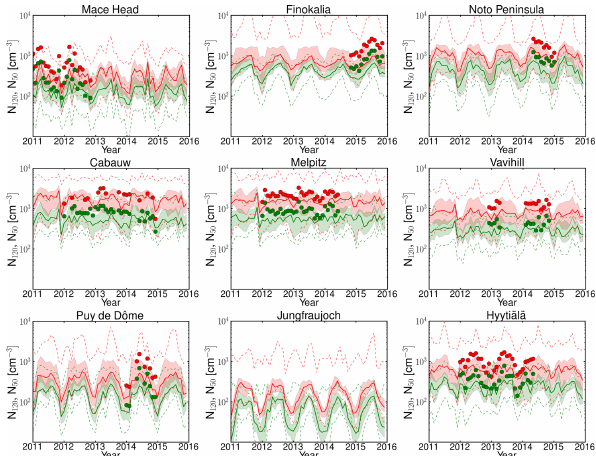
Figure 6. Monthly ensembles for the period 2011–2015 of the num- ber concentration of particles with diameters larger than 50nm (N 50 – in red) and 120nm (N 120 – in green). The continuous lines cor- respond to the median of the models for each month; the shaded areas show the 25% and 75% quartiles and the dashed lines the minimum and maximum of all models for the N 50 (red area) and N 120 (green area). Observational data are available for all stations except Jungfraujoch and are shown with symbols of the correspond- ing